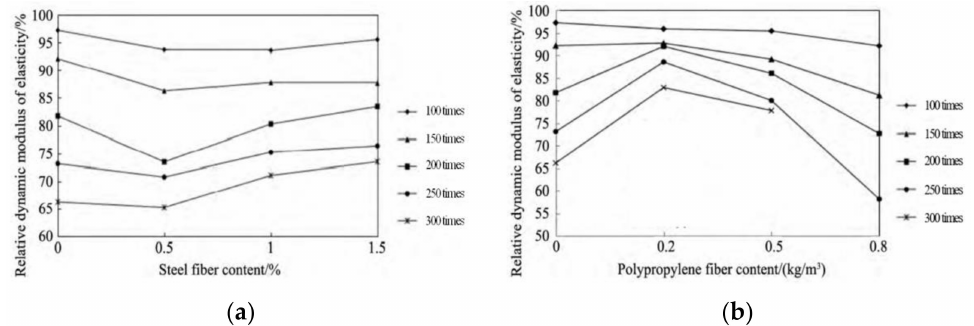
Figure 14. Effect of different fiber content on relative dynamic elastic modulus [135]: ( a ) Steel fiber; ( b ) Polypropylene